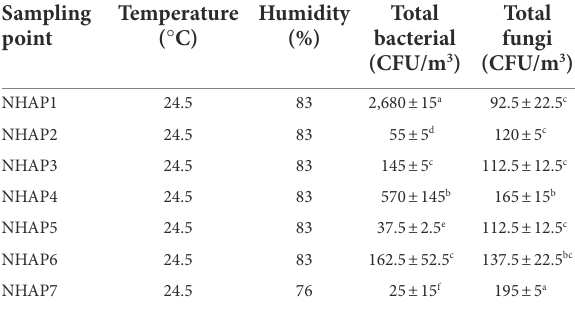
TABLE 3 Total bacterial and fungal concentrations, temperature, and humidity in the air at each sampling point in 2020.